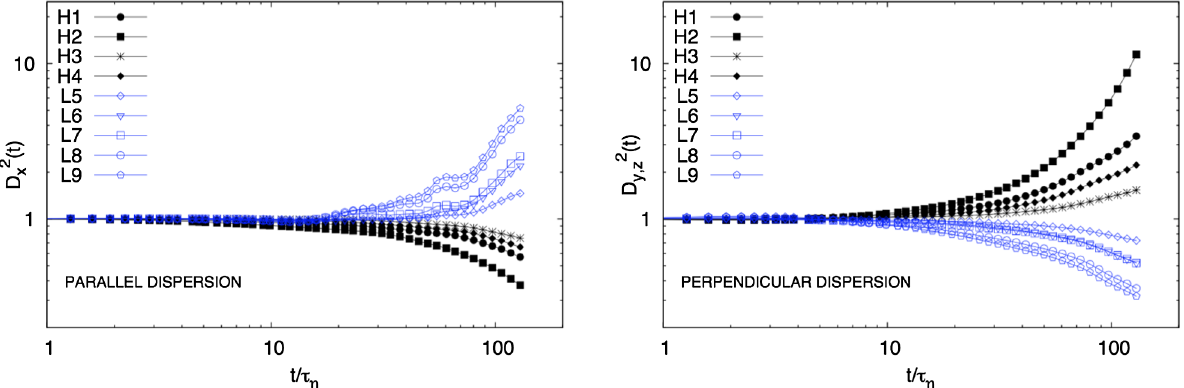
FIG. 10. Absolute dispersion of inertial particles in the direction parallel (left) and perpendicular (right) to the rotation axis. The mean-square displacement of inertial particles is normalized with that of tracers. Labels refer to the four families of heavy particles H 1 – H 4 and to the five families of light particles L 5 – L 9 . See Table II for details. Data refer to the DNS with N ¼ 2048 and Ω ¼ 10